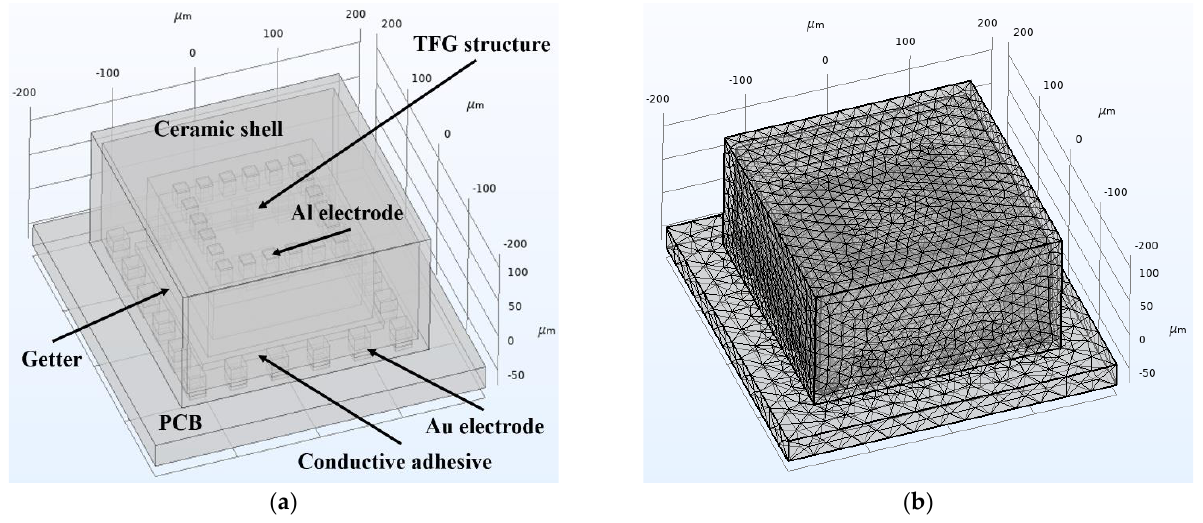
Figure 8. ( a ) Simulation model and ( b ) grid model of our packaged TFGs. Table 2. Dimensions and essential material parameters of components in the simulation model.